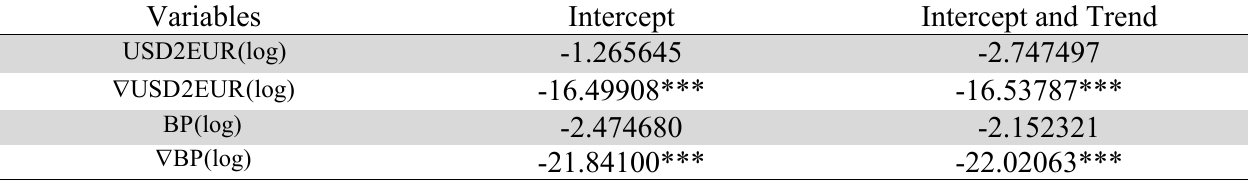
Augmented Dickey-Fuller test